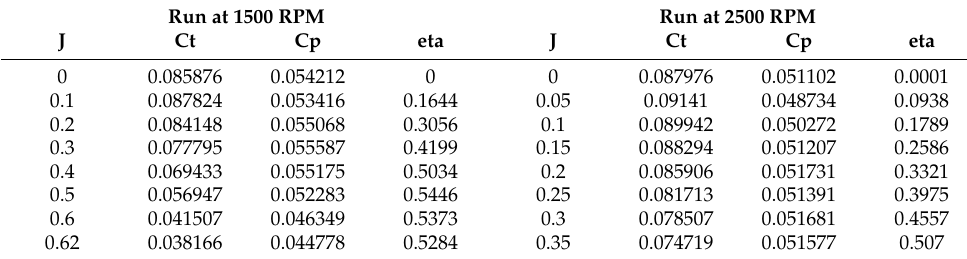
Table A19. BEMT 16 × 12 APC propeller